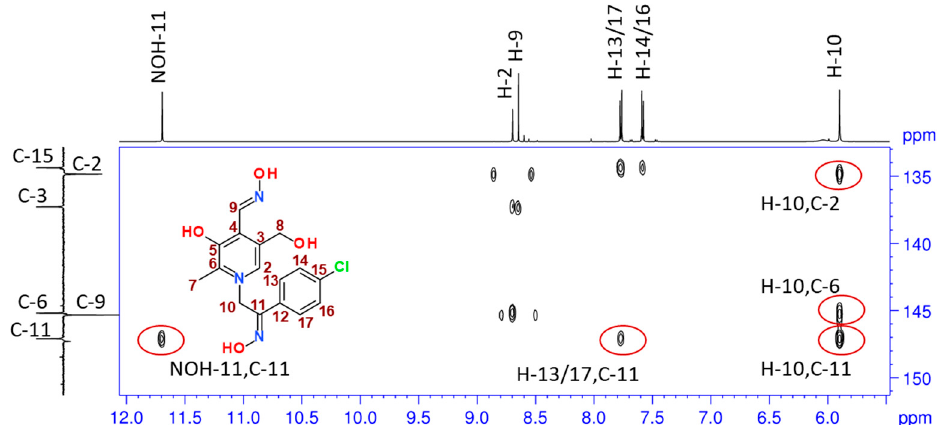
Figure 4. Part of the 1 H- 13 C HMBC spectra (600 MHz, DMSO-d 6 ) of 3 . The ovals indicate cross peaks, important for the assignment and confirmation of the synthesized compound. The part of the 1 H NMR spectrum is shown at the top and part of the 13 C NMR spectrum is shown at the left edge. The 1 H and 13 C spectra of compounds 3 , 4 , 6 , and 7 showed only one set of signals. Two isomeric forms, labeled (a) and (b) in Section 4, were found in the spectra of 1 , 2